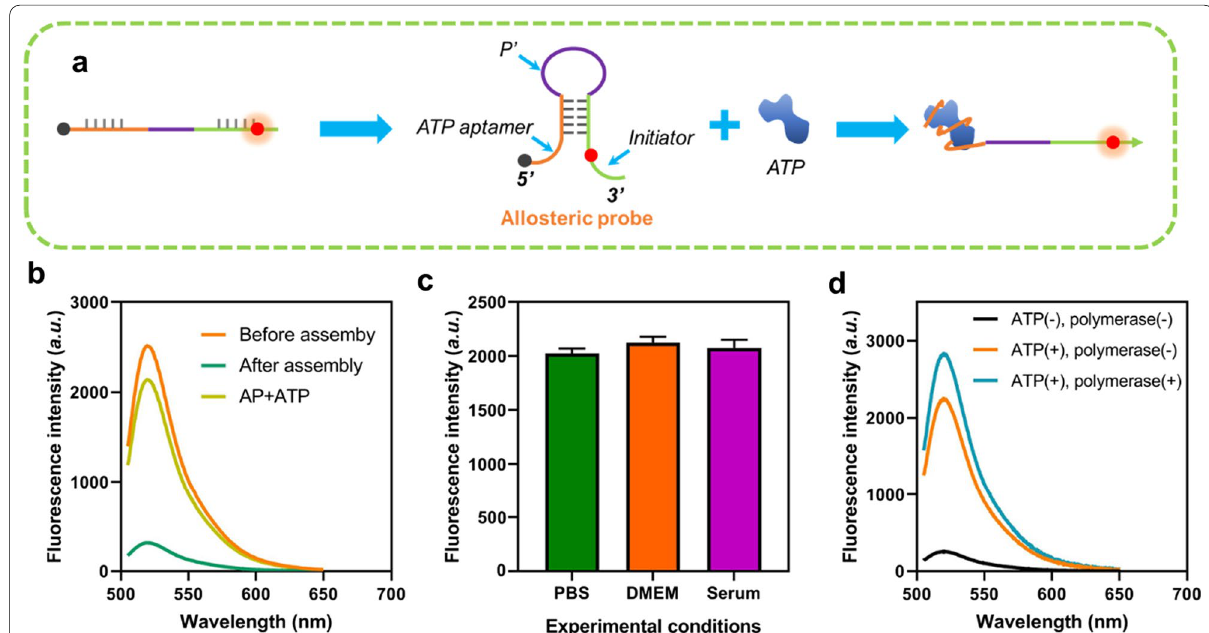
Fig. 2 Feasibility allosteric probe initiated triple signal recycles. a Illustration of assembly of allosteric probe; b fluorescence spectrum of allosteric probe during the assembly process; c fluorescence intensity of allosteric probe when incubated in different buffer solutions; d fluorescence spectrum of the approach when ATP and DNA polymerase existed or